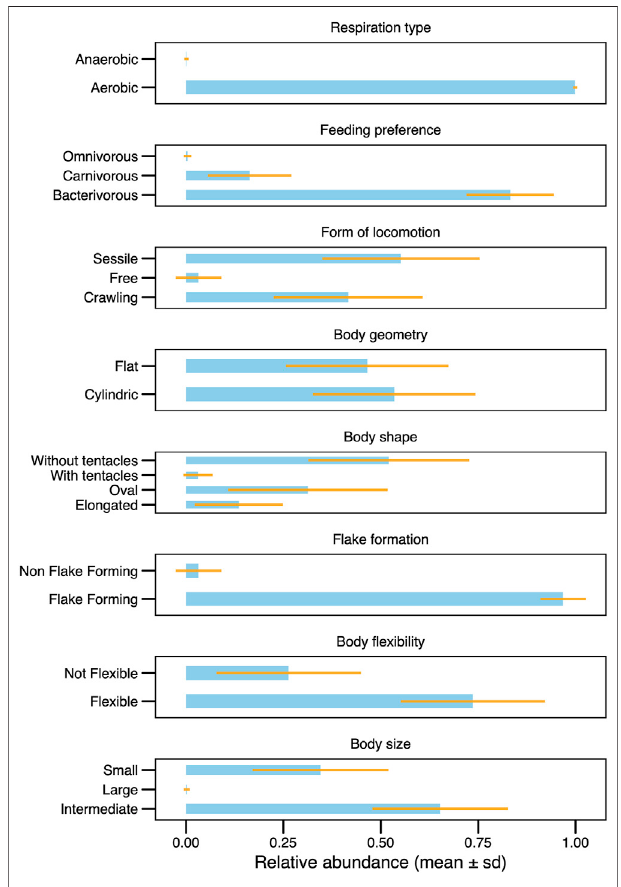
FIGURE 3 | Mean values of CWM, showing and summarizing the functional characteristics in the ciliate community.